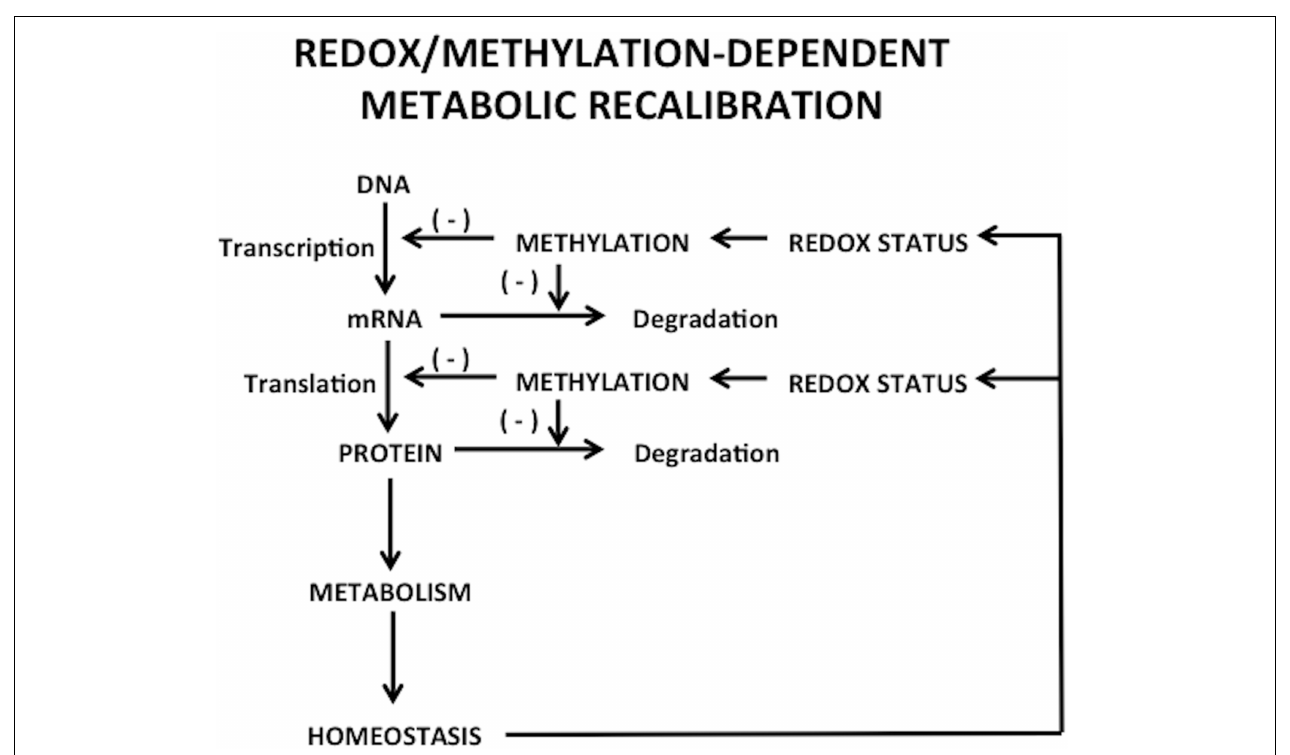
FIGURE 1 | Bidirectional regulation between transcriptional/epigenetic changes and metabolic homeostasis.